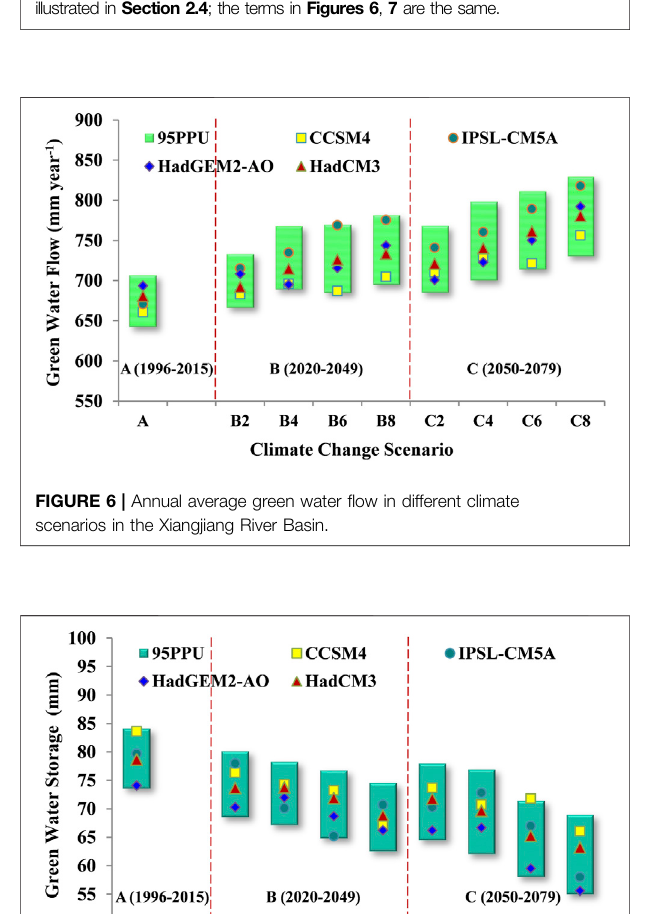
Frontiers in Earth Science |